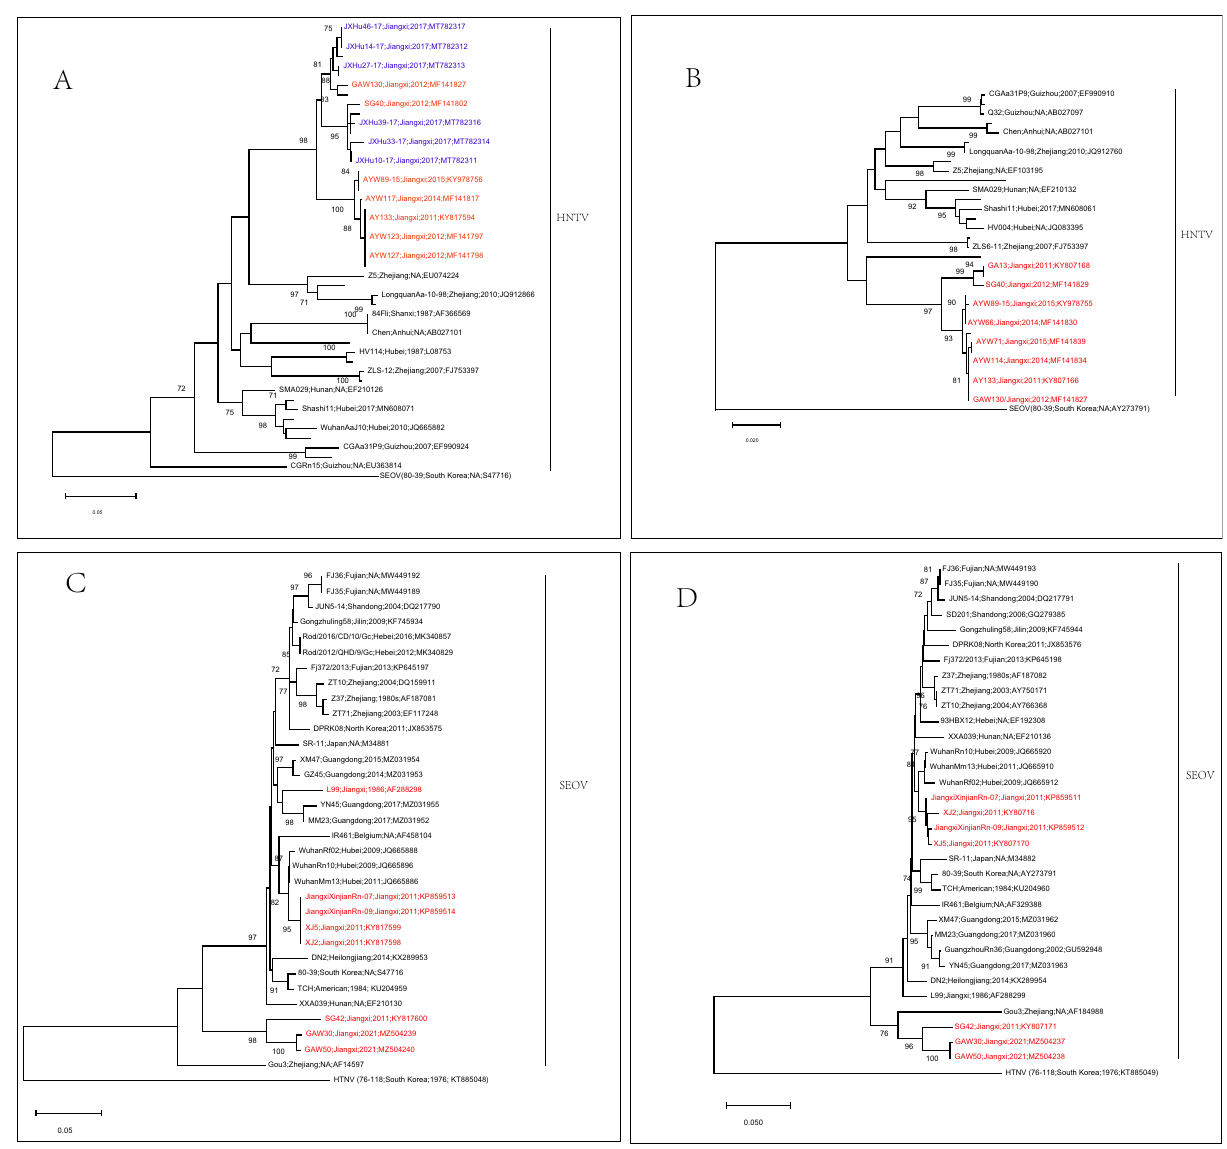
Figure 6. Genetic phylogenetic tree of hantavirus in Jiangxi and its surrounding provinces. ( A ): HTNV M gene; ( B ): HTNV S gene; ( C ): SEOV M gene; ( D ): SEOV S gene. The blue font indicates the virus strains isolated from human specimens in Jiangxi; the red font indicates the virus strains isolated from rodent specimens in